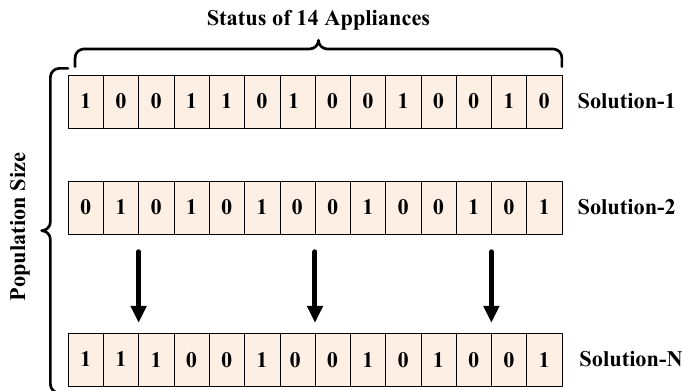
Figure 3. Hybrid bacterial flower pollination algorithm numerical